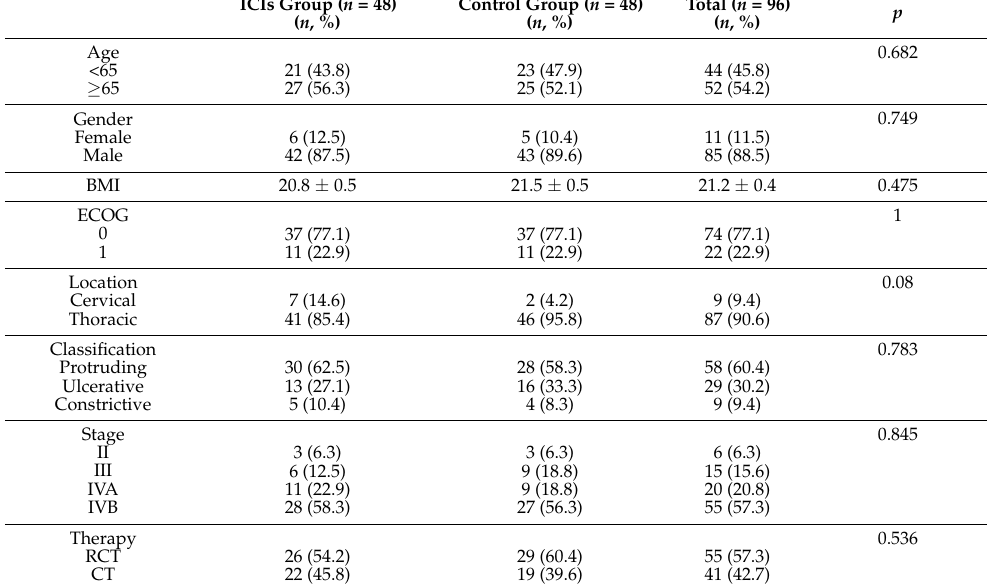
Table 1. Clinical characteristics of